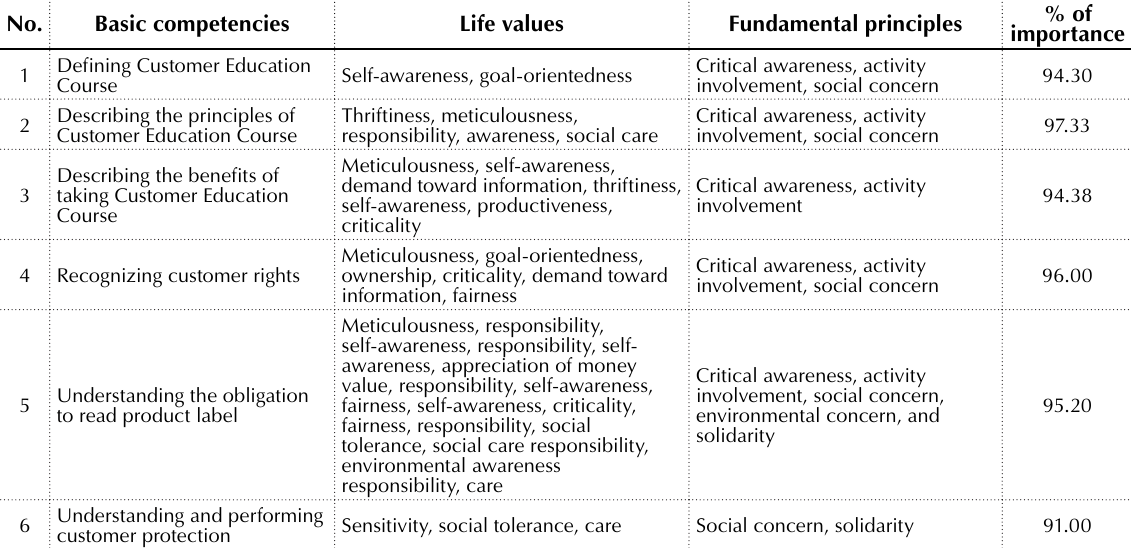
Table 3. Mind map of students’ perception on the importance of Customer Education based on fundamental